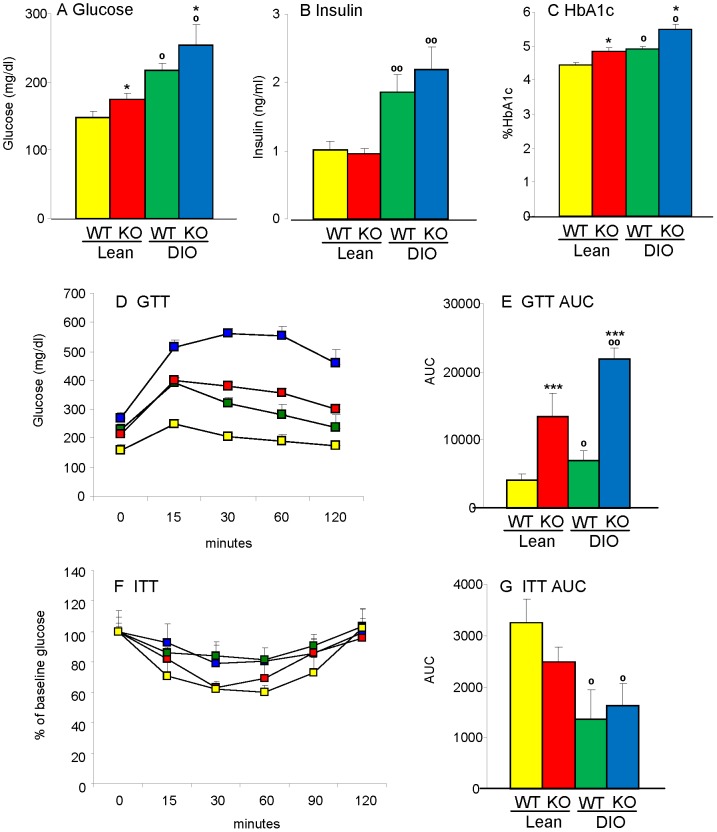
Glucose intolerance in Gal-3 KO mice.Parameters of glucose and insulin tolerance were evaluated in Lean WT (yellow), Lean Gal-3 KO (red), DIO WT (green) and DIO Gal-3 KO (blue) mice. Glucose (A), insulin (B) and% HbA1c (C) were evaluated in 4-hour fasted mice. Glucose tolerance test (D) was performed on 4-hour fasted mice. The area under the cruve for GTT is shown in E. Insulin tolerance test (F) was performed on fed mice. The area under the cruve for ITT is shown in G. Data are mean+/−SEM, n = 10 for A–C, n–5 for D–G. *p<0.05, ***p<0.001 versus respective WT group; °p<0.05, °°p<0.01 versus respective Lean group.